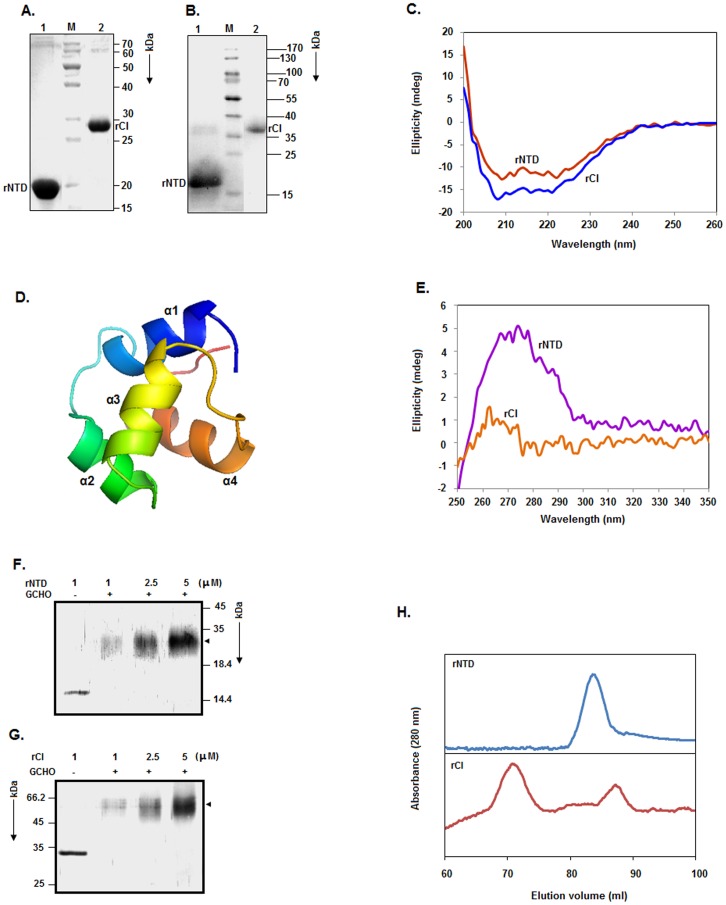
Purification and properties of rNTD and rCI.(A) 13.5% SDS-PAGE analysis of the elution fractions prepared from the SAU1315 (lane 1) and SAU1304 (lane 2) cell extracts. The rNTD- and rCI-specific protein bands are indicated. The molecular masses (in kDa) of the marker protein bands (M) are shown on the right side of the gel. (B) Western blot analysis of the elution fractions prepared from the SAU1315 (lane 1) and SAU1304 (lane 2) cell extracts. The rNTD-, rCI-, and marker protein-specific bands are noted. (C) Far UV CD spectra of rNTD and rCI. (D) Three-dimensional structural model of the N-terminal domain of Φ11 CI. (E) Near UV CD spectra of rNTD and rCI. (F, G) Chemical crosslinking of rNTD and rCI. The proteins were treated separately with glutaraldehyde (GCHO), followed by analysis using 13.5% SDS-PAGE. The arrowheads indicate the dimer-specific protein band. The molecular masses (in kDa) of the marker protein bands are shown on the right or left side of the gels. (H) Gel filtration chromatography of rNTD and rCI by a standard procedure, as described in the Materials and Methods section.